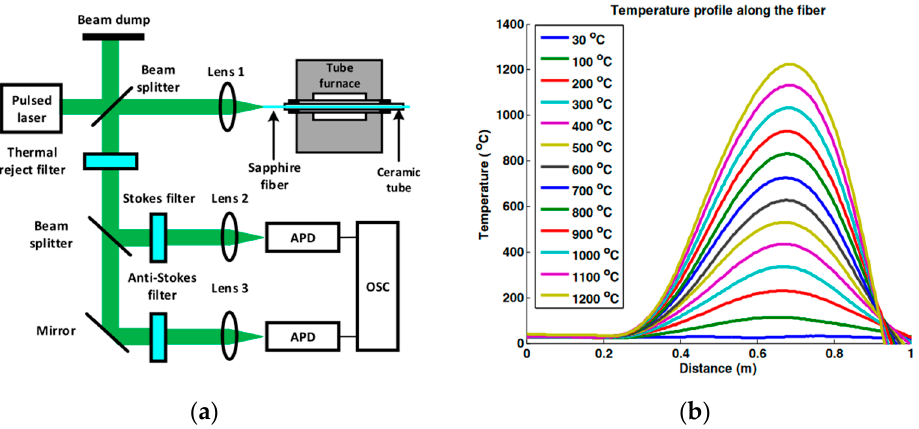
Figure 16. Schematic diagram of the PbP SFBG fabrication process and temperature test results. (Reprinted with permission from Ref. [185].) ( a ) Schematic of the experimental setup for Raman DTS system; ( b ) Demodulated temperature profile along the sapphire fiber.